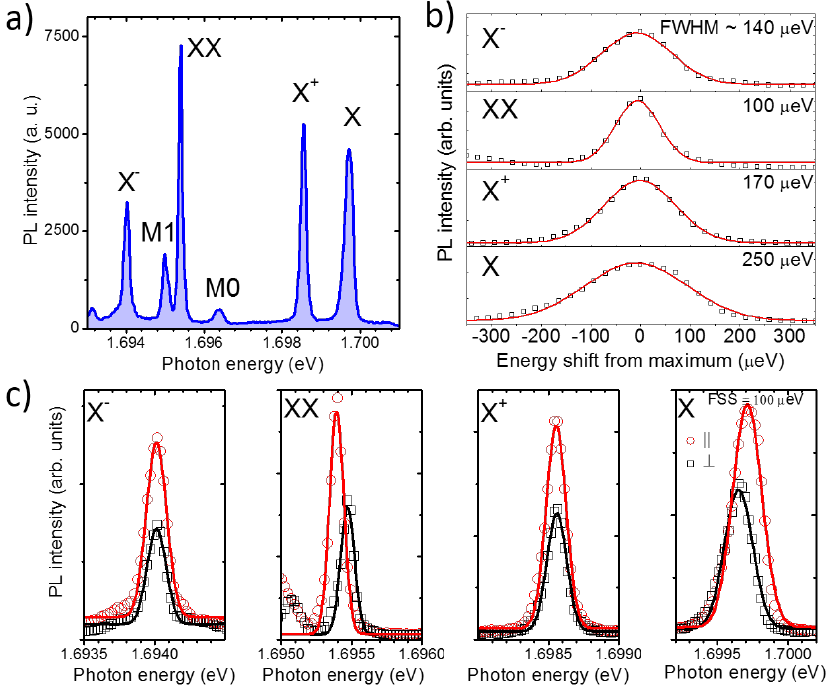
Figure 2. ( a ) PL spectrum of a single GaAs QDs sandwiched between (311)A Al 0.35 Ga 0.65 As barrier layers. The labels on the most intense lines X, X + , XX, and X − highlight, respectively, the emission from the neutral exciton, the positive charged exciton, the neutral biexciton, and the negative charged exciton. M0 and M1 highlight other non-attributed multiexciton complexes. ( b ) Symbols: PL spectra of X, X + , XX, and X − (respectively, from the bottom to the top panel). Red lines are Gaussian fit to the data. The corresponding full width at half maximum (FWHM) is reported on each panel. ( c ) Linearly polarized components of X, X + , XX, and X − PL (respectively, from the right to the left panel). Red and black symbols indicate orthogonal polarization. The continuous lines are Gaussian fits. The fine structure splitting (FSS) measured from the X and XX components is ~100 µ